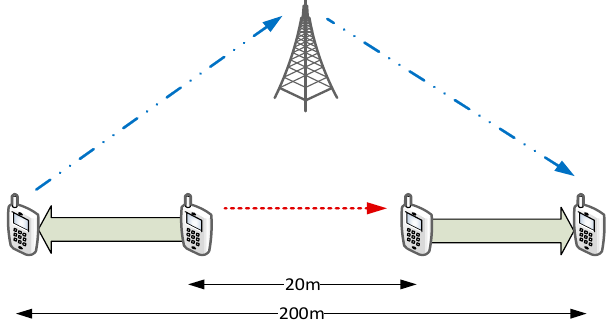
Figure 21. Simulation scenario for assessing the impact of MS.